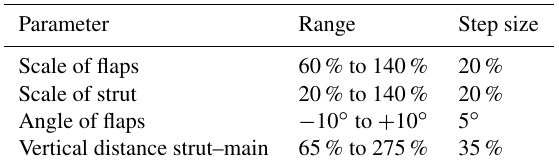
Table 1. Summary of varied parameters; 100% refers to the base- line